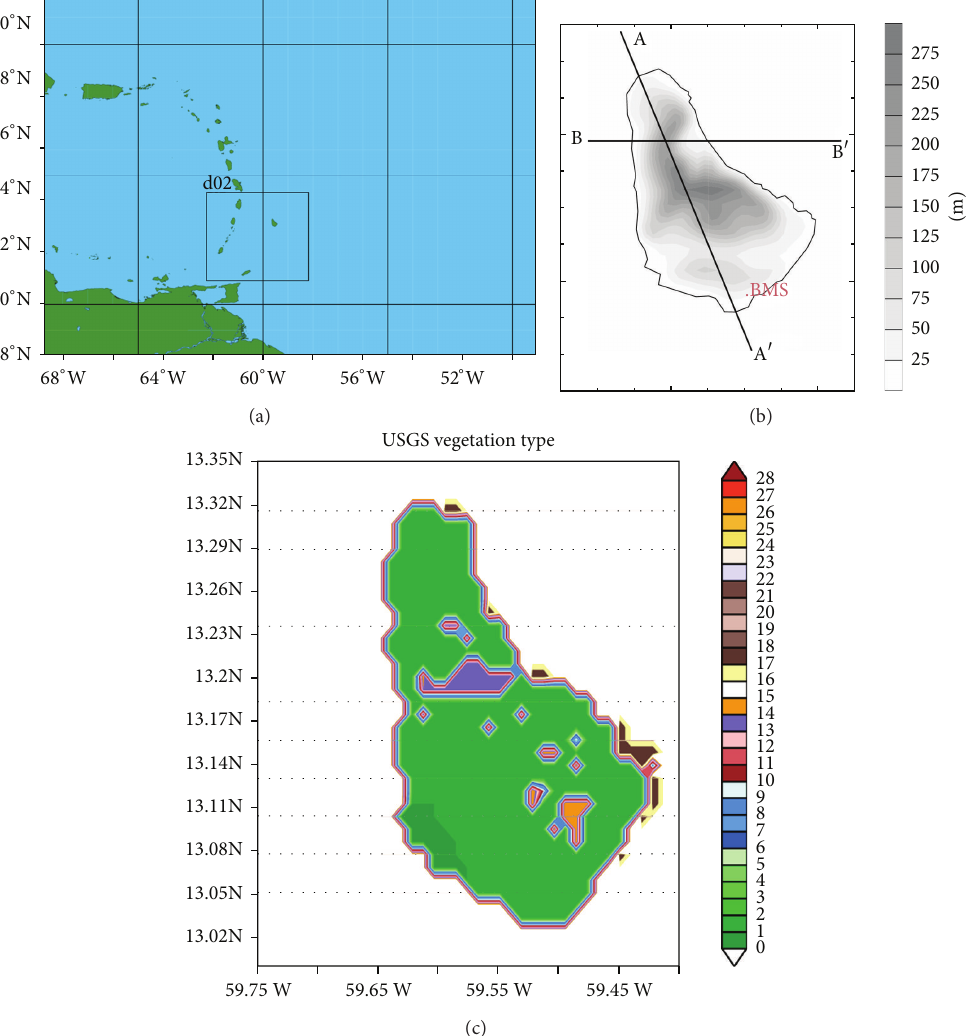
Figure 3: (a) WRF domains used in the simulations. The label BMS indicates the location of the Barbados Meteorological Office, (b) the WRF representation of the topography of Barbados (in m), and (c) the WRF representation of the vegetation type for Barbados. AA 󸀠 and BB 󸀠 denote the cross-sections for the following